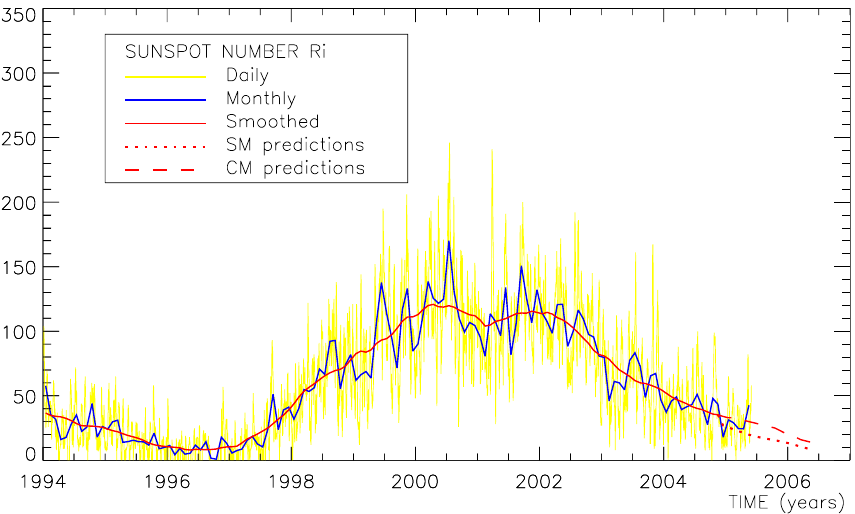
Fig. 8. The last 12 years of sunspot data published by the SIDC, showing the most relevant sunspot numbers and medium-term forecast